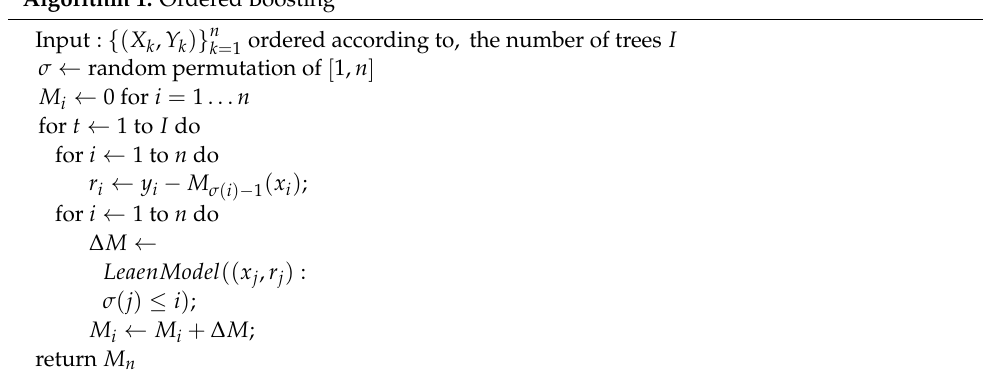
Algorithm 1: Ordered